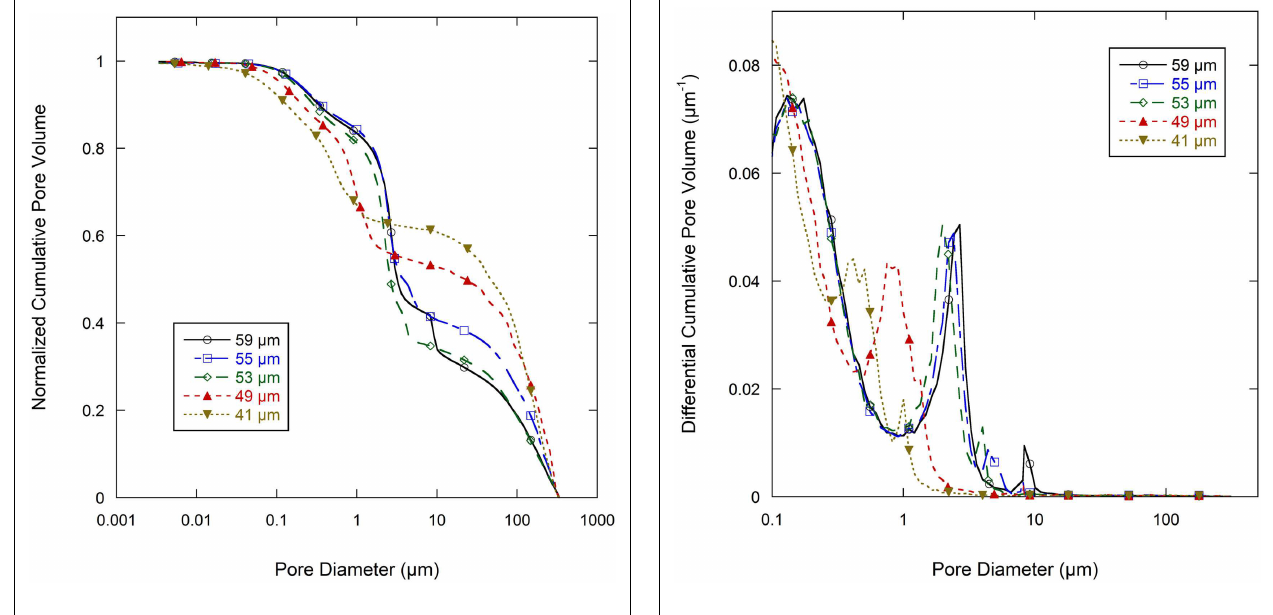
FIGURE 5 | Slope of normalized cumulative intrusion curve for all graphite anode electrodes films .